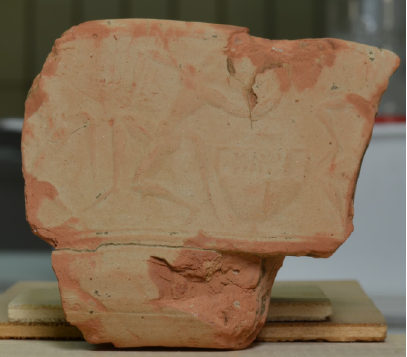
Figure 4. Potsherd decorated with Komòs scene.